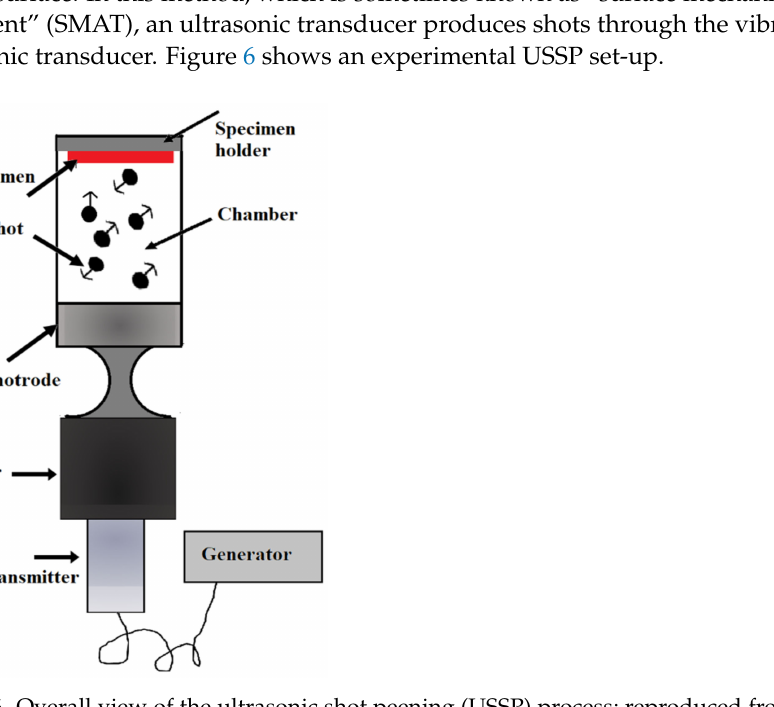
Figure 6. Overall view of the ultrasonic shot peening (USSP) process; reproduced from [57], with permission from Elsevier,